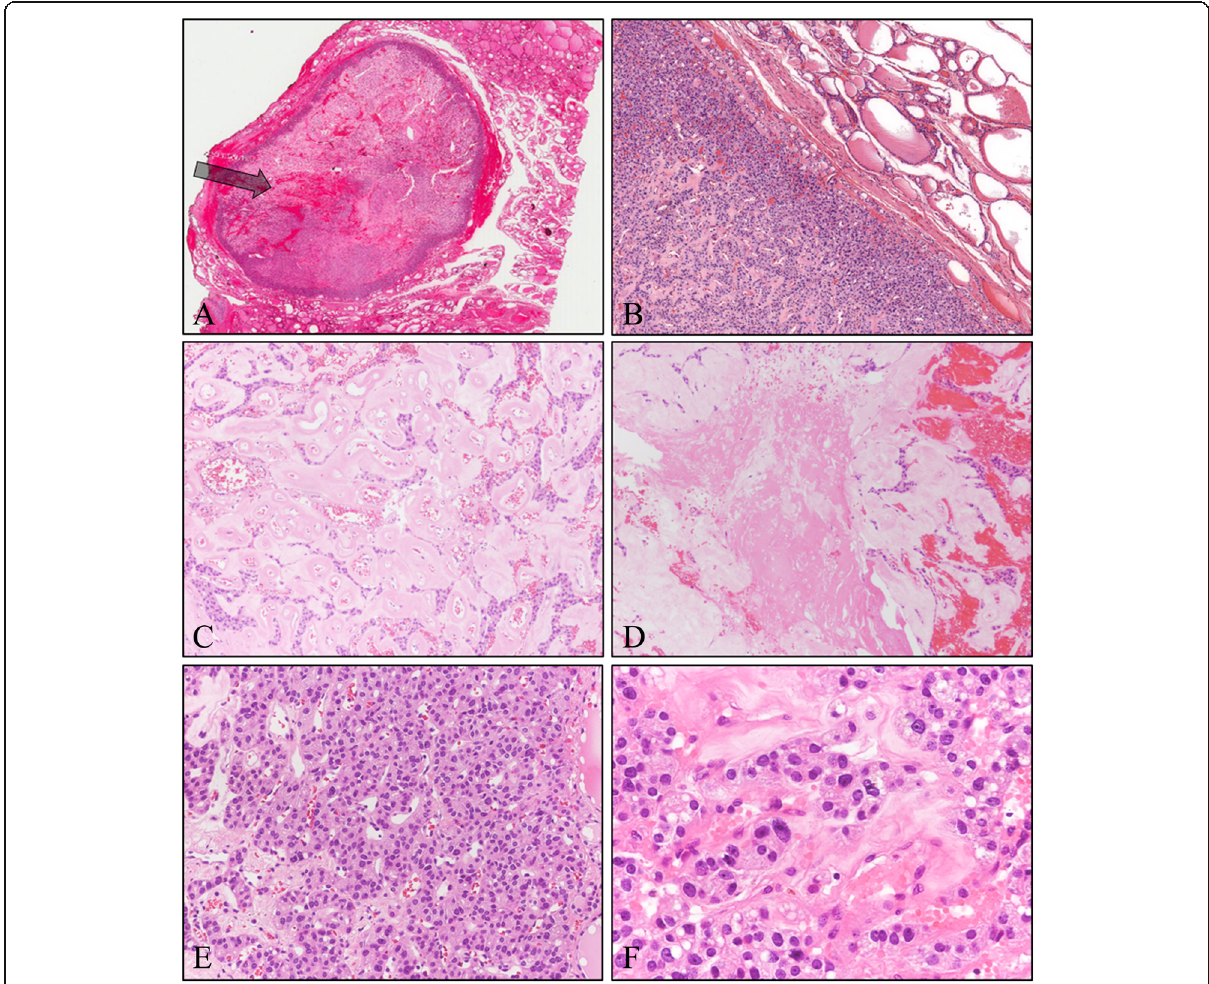
Fig. 3 Histological features of the mass observed from a permanent section. a At scan view, the tumor shows well-margination and needle tract- like structure (arrow) (H&E stain; original magnification, scan view). b The tumor showing thin but obvious fibrous capsule (H&E stain; original magnification, × 40). c The tumor cells showed trabecular growth patterns with intersecting homogenous eosinophilic materials (H&E stain; original magnification, × 100). d Infarction-like necrotic area and hemorrhage is present in some areas of the tumor (H&E stain; original magnification, × 100). f The tumor cells showed amphophilic granular cytoplasm with round to oval nuclei and nucleoli in some cells (H&E